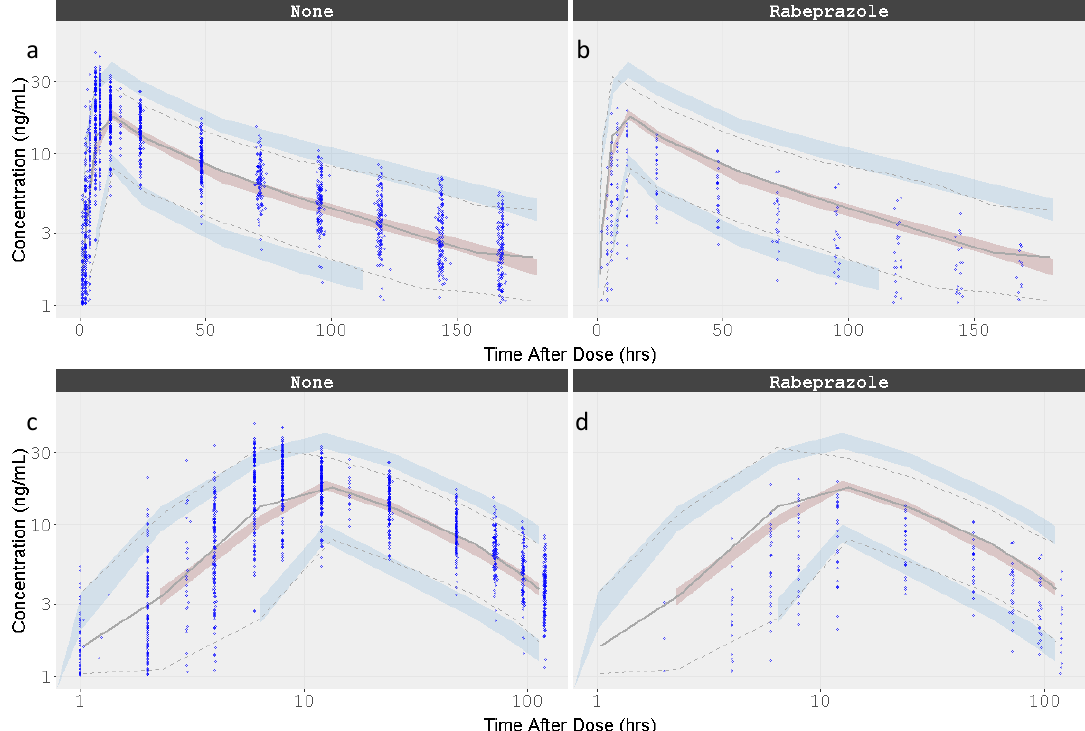
Figure 7. Visual Predictive Check for the Dacomitinib Final Model by Concomitant administration of Rabeprazole. Time is presented in linear and logarithmic scale to stretch the time around C max and better appreciate how well the absorption phase is captured. ( a ) Dacomitinib without rabeprazole co-administation; ( b ) Dacomitinib with rabeprazole co-administation; ( c ) Dacomitinib without rabeprazole co-administation with time in the log scale; ( d ) Dacomitinib with rabeprazole co-administation with time in the log scale. Observed data are presented in blue circles with the 50th percentile of the observed data represented by the solid blue line and the 5th and 95th percentiles of the observed data represented by the dotted blue lines. Red shaded region represents the prediction interval for the 50th percentile. Blue shaded regions represent the prediction intervals at the 5th and 95th